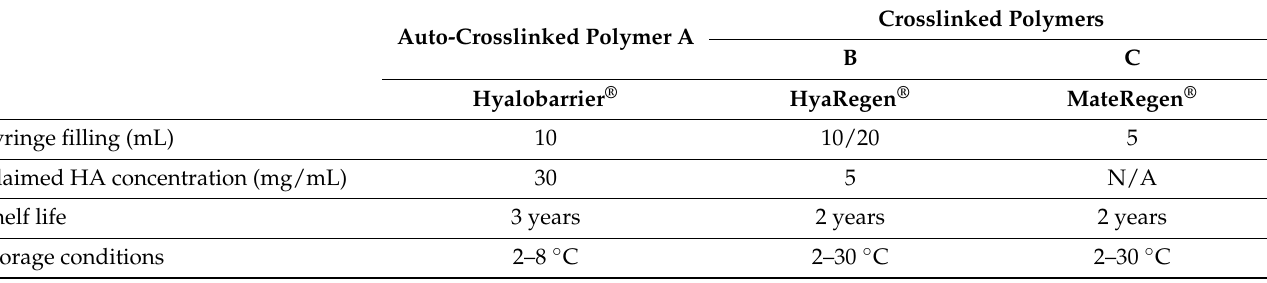
Table 1. Description of the